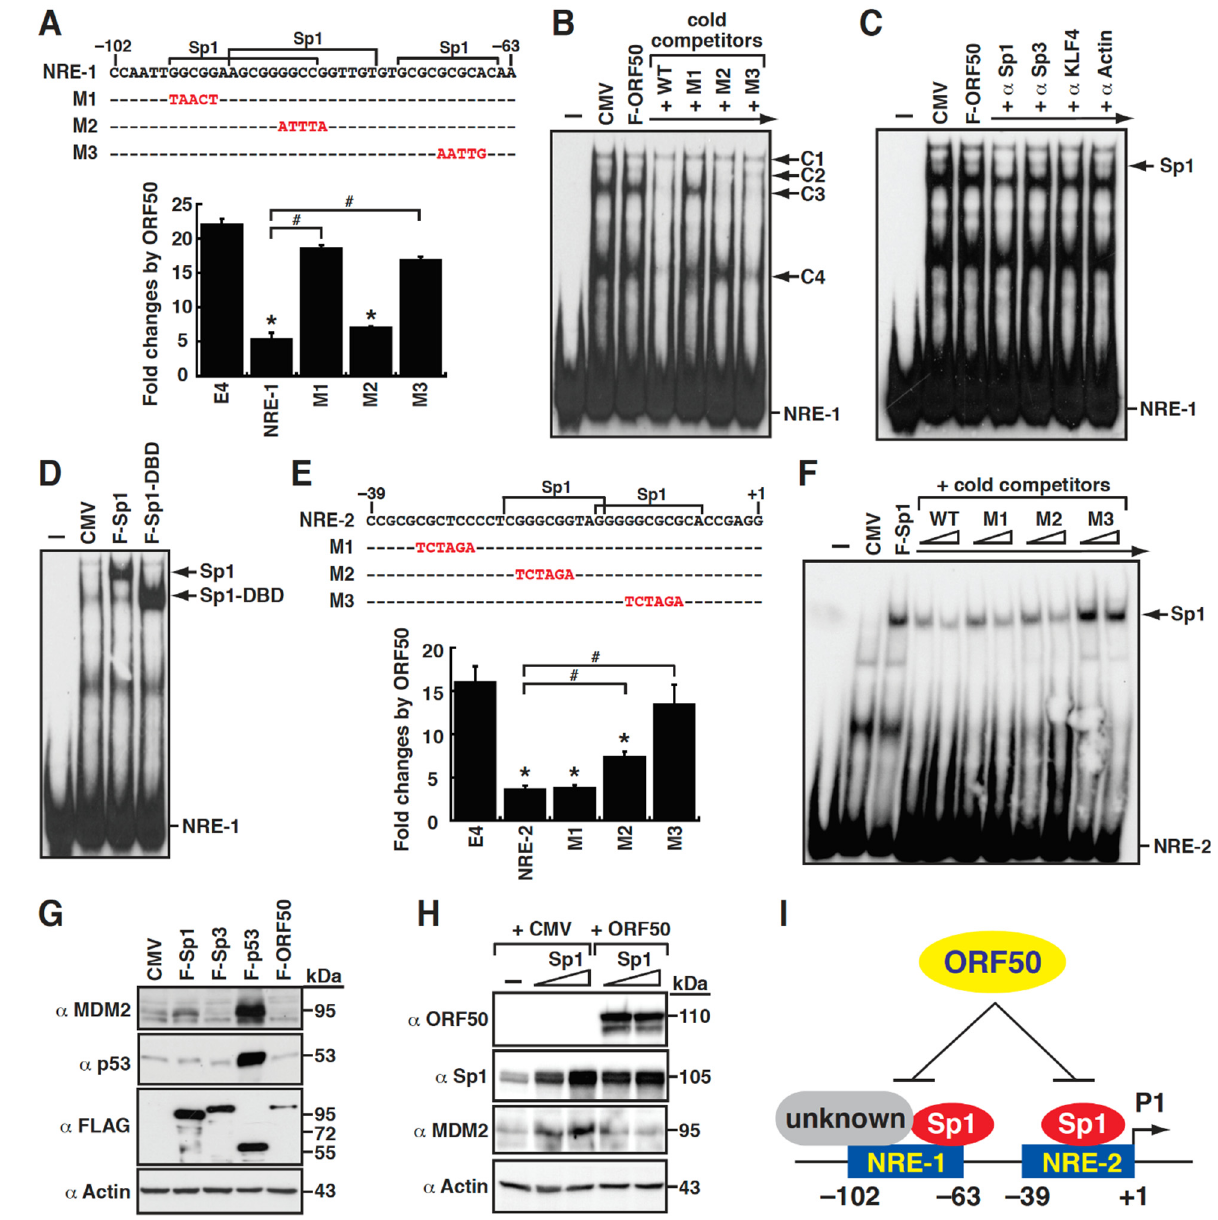
Figure 6. Sp1 is involved in the ORF50-mediated transcriptional repression of the P1 promoter of the MDM2 gene. ( A ) Point mutational analysis of the P1(–103/–63) promoter element (or referred to as NRE-1). The diagram shows the nucleotide sequence of NRE-1 and its mutated elements (top panel). Notably, there are three Sp1-binding sites predicted in the NRE-1 element. The responsiveness of the reporter constructs containing the NRE-1 element or its mutants (M1, M2, and M3) to ORF50 was assayed in 293T cells (bottom panel). *, p < 0.05, compared to pE4-luc; #, p < 0.05, compared to the NRE-1 group (n = 3). ( B ) EMSA analysis of the NRE-1 element using total protein extracts of 293T cells transfected with the empty vector or the ORF50 expression plasmid. Four major protein/DNA complexes (C1, C2, C3, and C4) were detected in the EMSA. Cold competitors shown in panel ( A ) were added at a concentration of a 50-fold molar excess relative to the labeled probe. ( C ) Antibody supershifting or blocking test in EMSA. Specific antibodies to Sp1, Sp3, KLF4, or actin were used for EMSA supershift or blockade assay. ( D ) Direct binding of Sp1 or the Sp1 DNA-bind- ing domain (Sp1-DBD) to the NRE-1 element. EMSA was performed using total protein extracts of 293T cells transfected with the empty vector or the plasmid expressing the full-length Sp1 or Sp1- DBD. ( E ) Point mutational analysis of the P1(–39/+1) promoter element (or referred to as NRE-2). The nucleotide sequences of NRE-2 and its mutated elements are shown in the diagram (top panel). Note that there are two Sp1-binding sites predicted in the NRE-2 element. The responsiveness of the